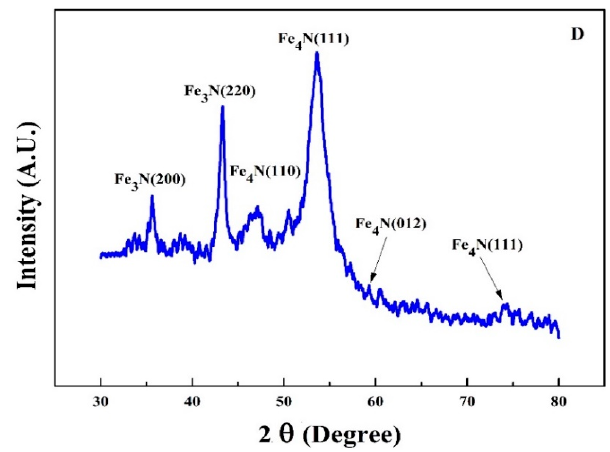
Figure 5. The XRD pattern of sample D the iron nitride thin film deposited on both sides of PET.